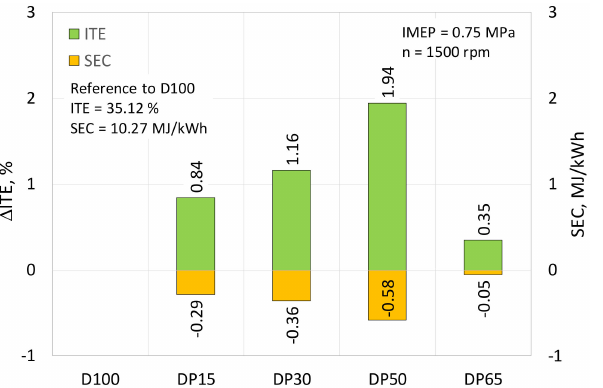
Figure 7. Thermal efficiency (ITE) and specific energy consumption (SEC) of a dual-fuel engine fueled by diesel and propanol with alcohol content from 0 to